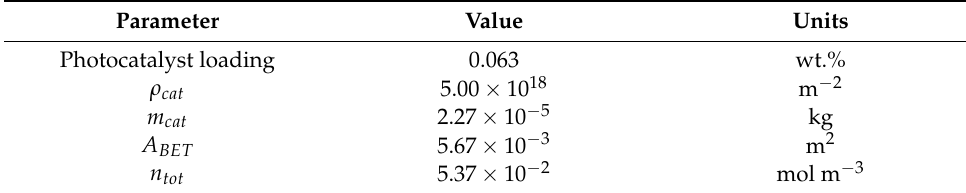
Table 2. Photocatalyst